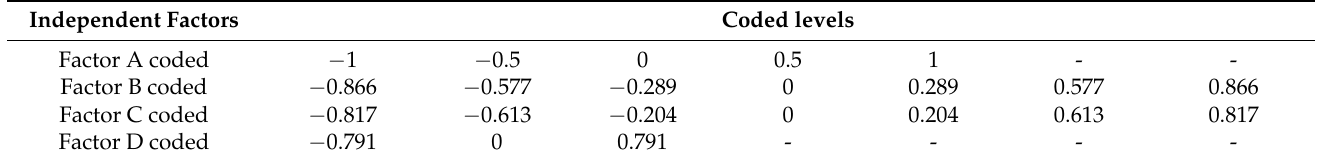
Table 2. Independent factors and their coded levels in the Doehlert matrix design.